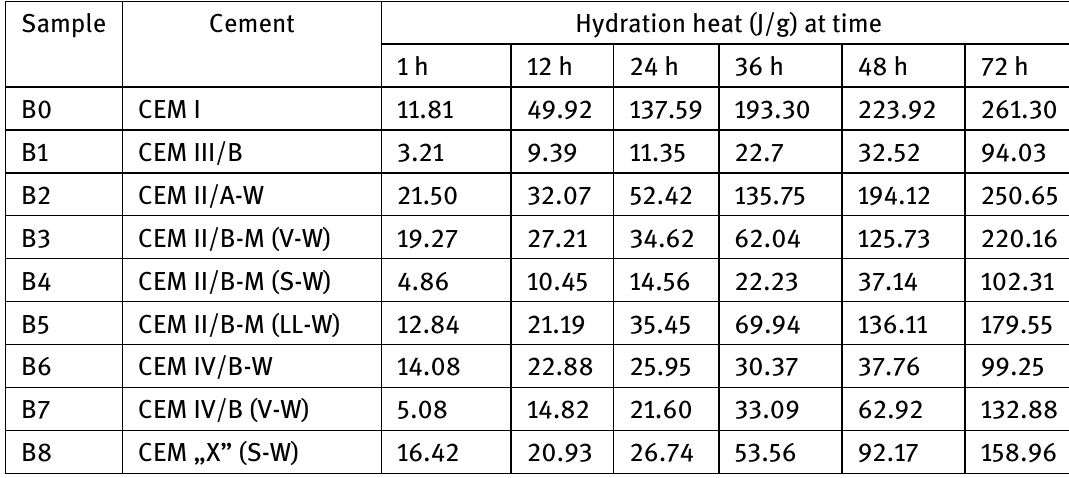
Table 3: Heat of hydration of cements with of SP (w/c = 0.54, SP content see Table 2)